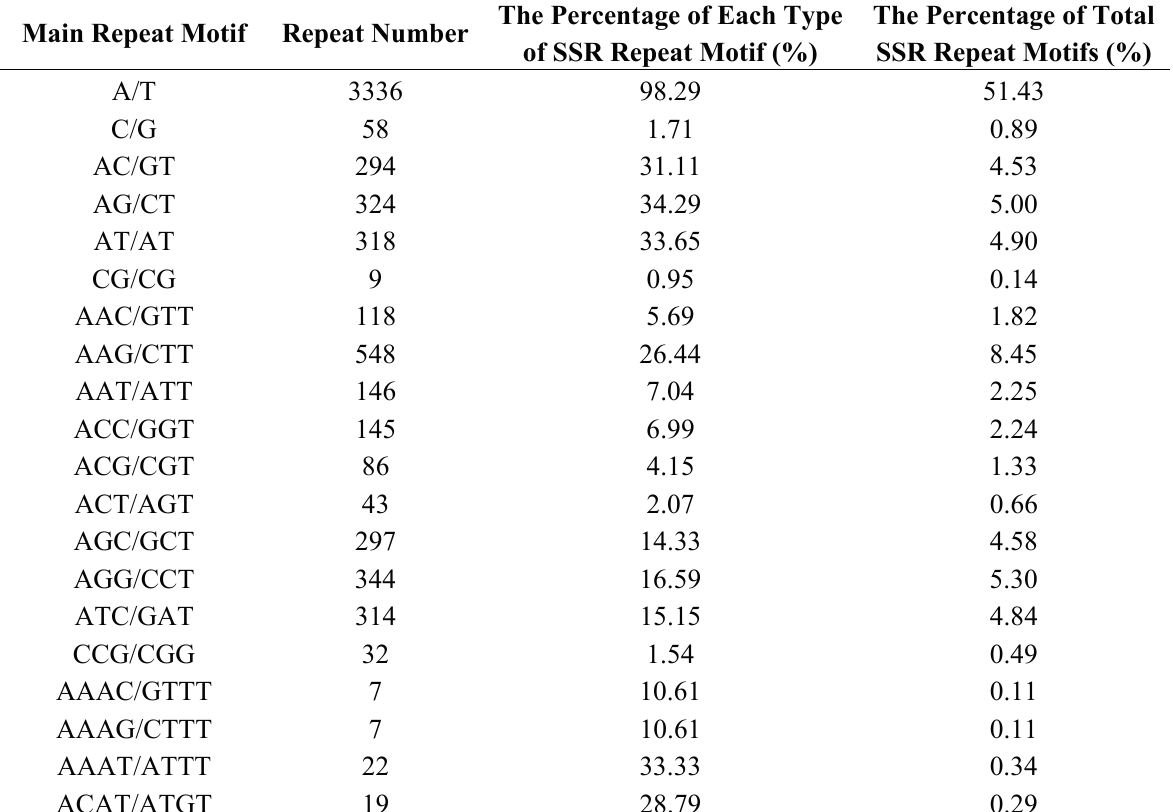
Table 2. Number and frequencies of the main repeat motif